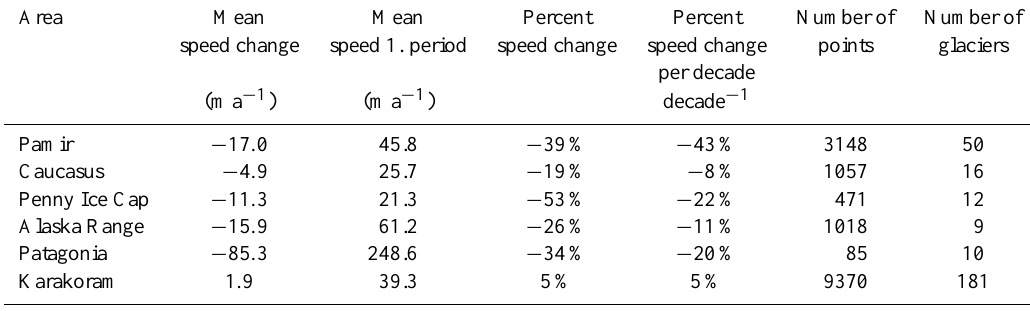
Table 5. Speed change for each area.